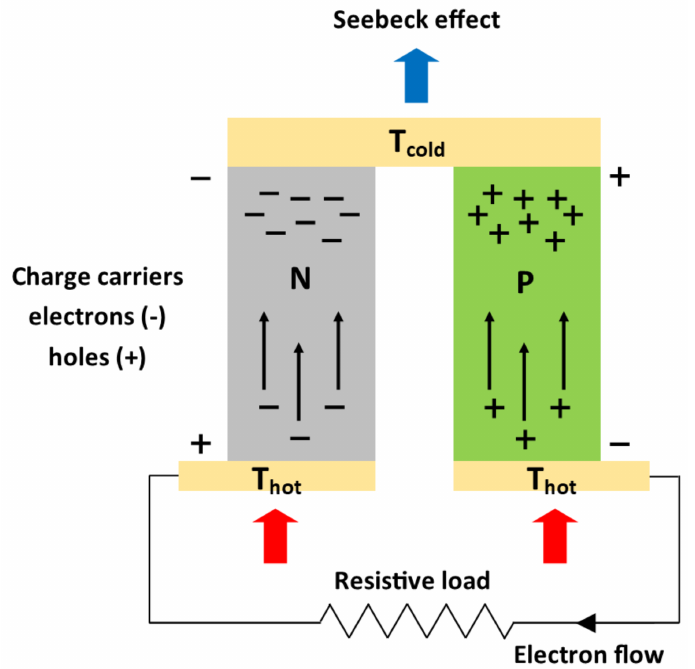
Figure 1. The principle of thermoelectric generation. The TEGs’ operation is determined by the temperature difference between the two sides of the generator. The hot electrons travel more quickly towards the cold side than the cold electrons moving towards the hot side. Consequently, the cold end of the TEG becomes negatively charged, and the hot end is positively charged. The operation of TEG is characterized by a relatively low conversion efficiency (~5%), but such a low value is not crucial because TEG is typically used for the recovery of waste heat [8,9]. The main advantages of using thermoelectric generators are as follows: no additional energy is required from the stove; almost no maintenance is required since thermoelectric generators do not include moving parts; and thermoelectric generators do not require a large battery system and work continuously in any weather conditions [10]. Generally, TEGs can be considered as additional power sources in the domestic sector, but they can also be